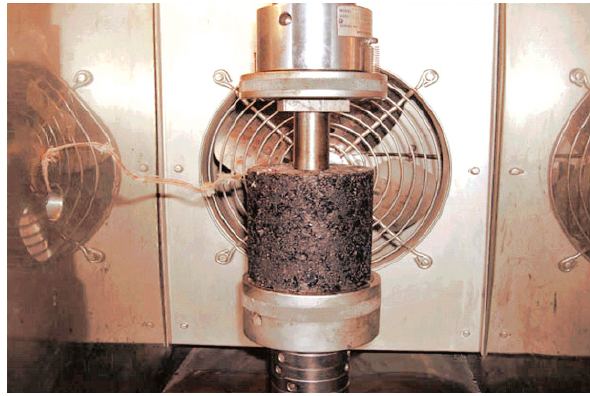
Figure 4. Uniaxial penetration test.